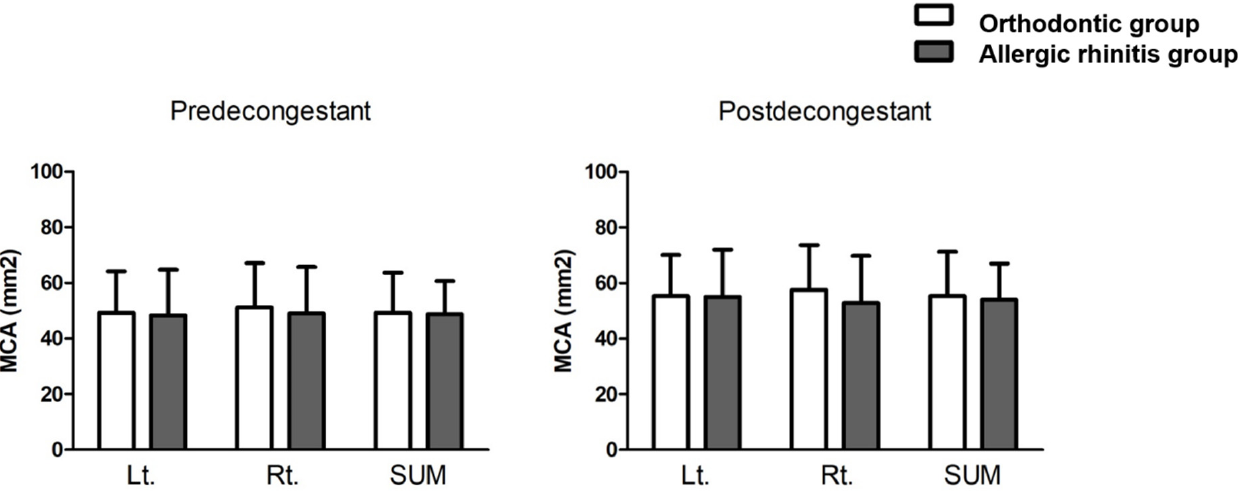
Figure 3. Comparison of minimal cross-sectional areas of nasal cavities measured in pre-decongestant and post-decongestant states between the orthodontic and allergic rhinitis groups. Paired t -test was used to compare the two groups. MCA, minimal cross-sectional area; Lt., left; Rt., right; SUM, average value of right and left nasal cavity.